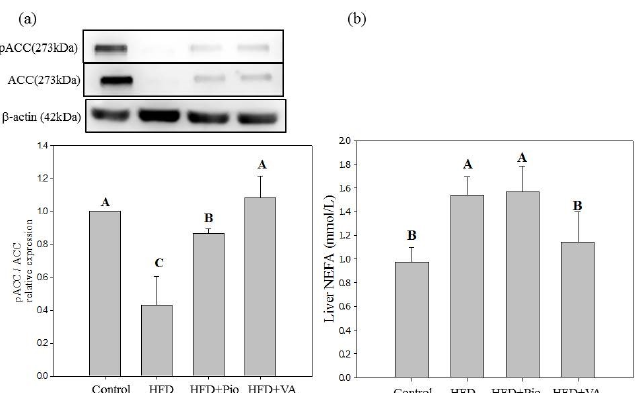
Figure 4. ( a ) Hepatic phosphorylated acetyl ‐ CoA carboxylase/acetyl ‐ CoA carboxylase (pACC/ACC) protein expression; and ( b ) non ‐ esterified free fatty acid (NEFA) in rats fed high ‐ fat diet for 16 weeks